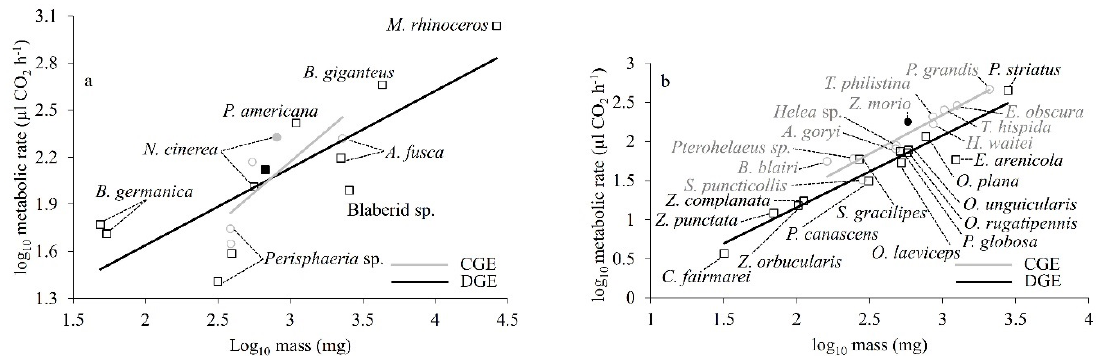
Figure 3. The relationships of log 10 metabolic rate and log 10 mass of ( a ) cockroach species, and ( b ) tenebrionid beetle species using either CGE or DGE. Data were corrected to a common measurement temperature of 23 °C, assuming a Q 10 value of value of 2.0. Filled symbols are for data points from our study and open symbols are for data points from the literature (circles, CGE; squares, DGE; see Supplementary Tables S3 and S4 for further information).